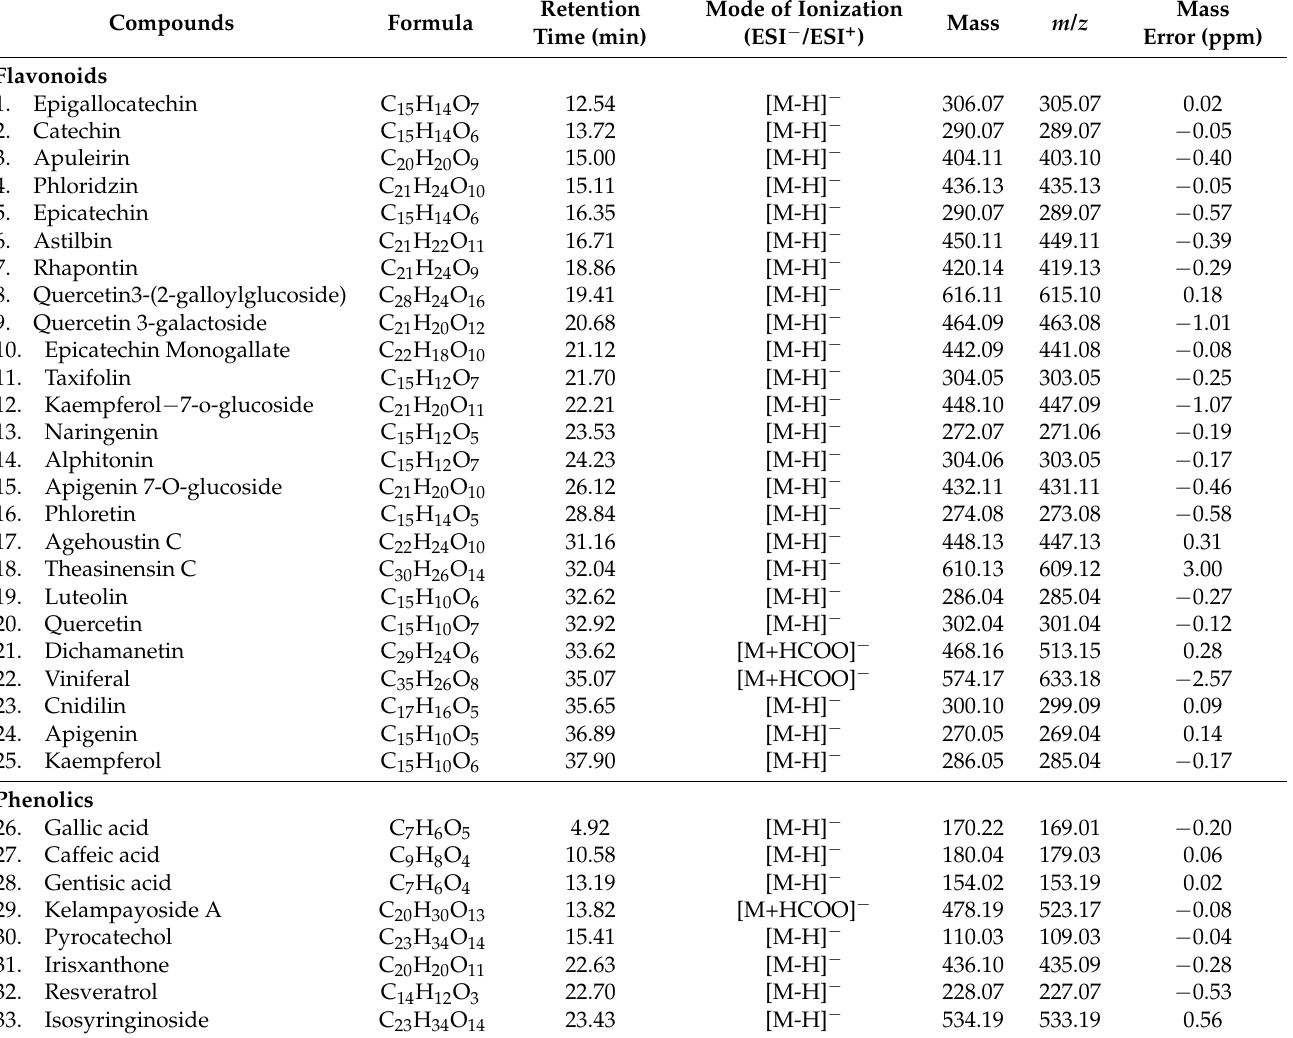
Table 2. Qualitative characterization of flavonoids and phenolics in BsE